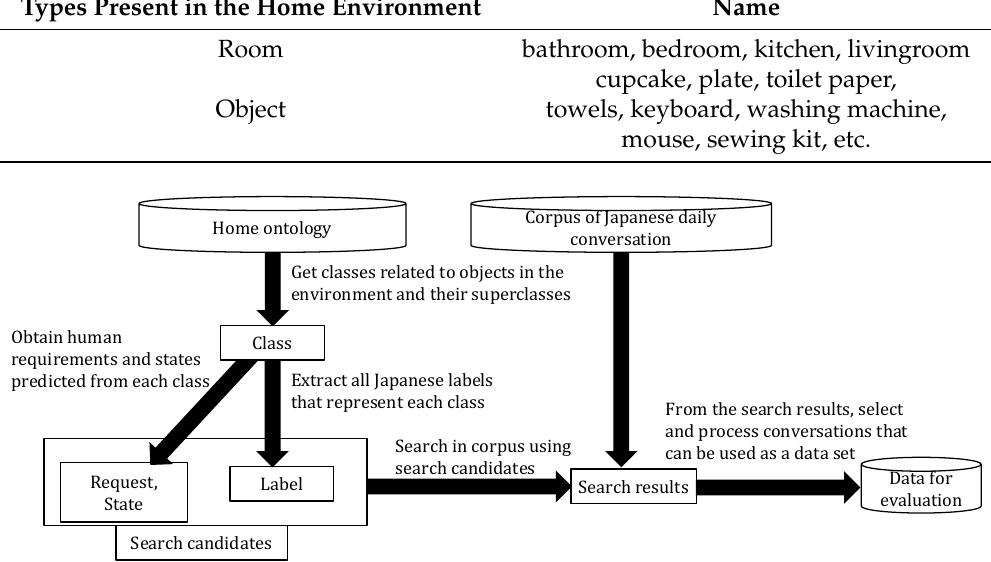
Figure 16. Procedure for creating a data set for